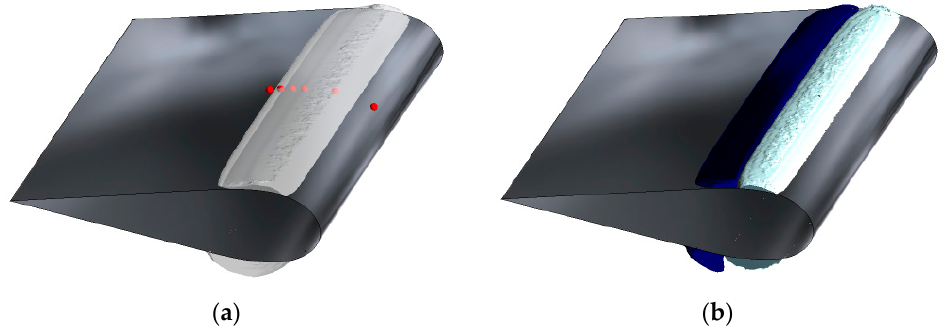
Figure 14. 3D view of cavitation at σ = 1.9. ( a ) Iso-surface of water volume fraction 90%. Red balls indicate positions of thermistor probes; ( b ) evaporation regions (in light cyan) and condensation regions (in dark blue). CFD.